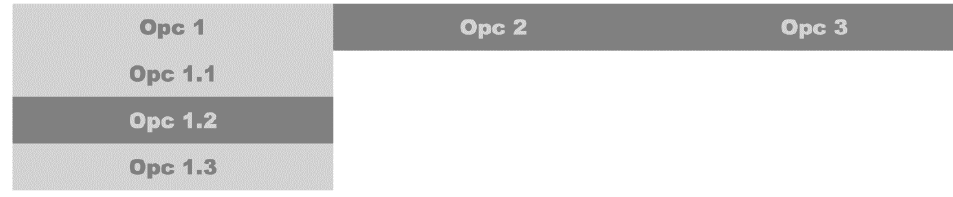
Figure 16. Visualization of the HTML code generated by the getMainObjects function returning a navigation menu